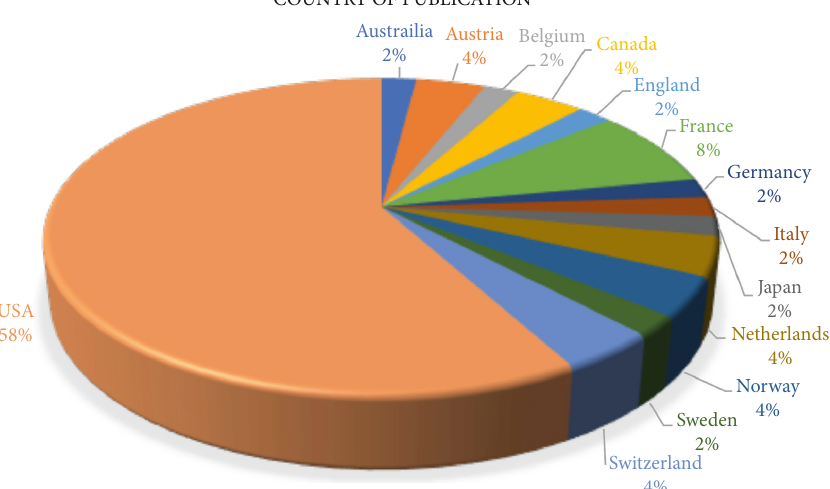
Figure 4: Country of publication.